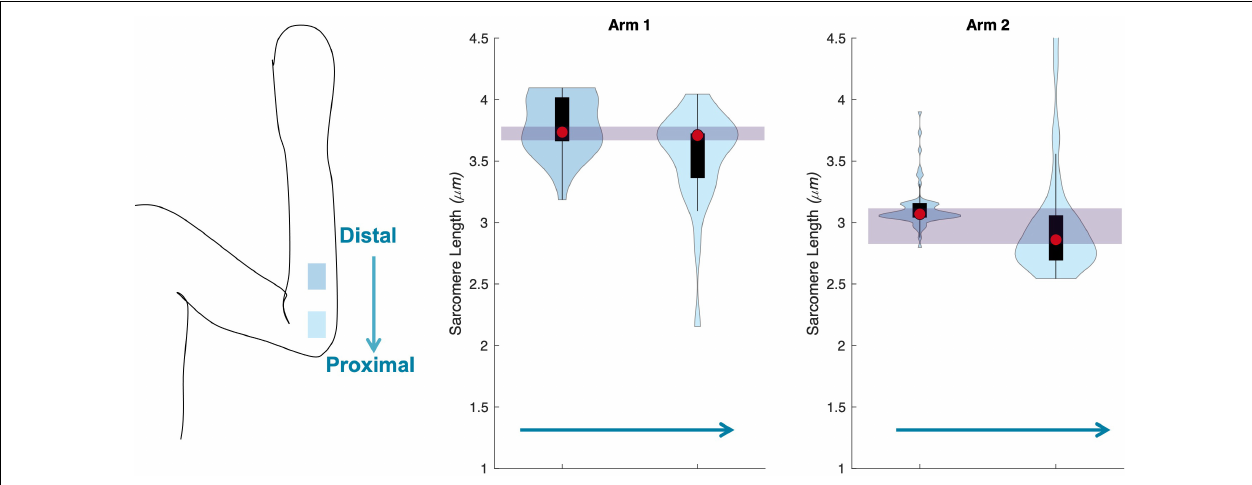
FIGURE 7 | Schematic of the two insertion locations (left) in the flexor carpi ulnaris., and three arms showing median of data (red circle), interquartile range (black box plot), and probability density of data at each location (shaded violin shape).